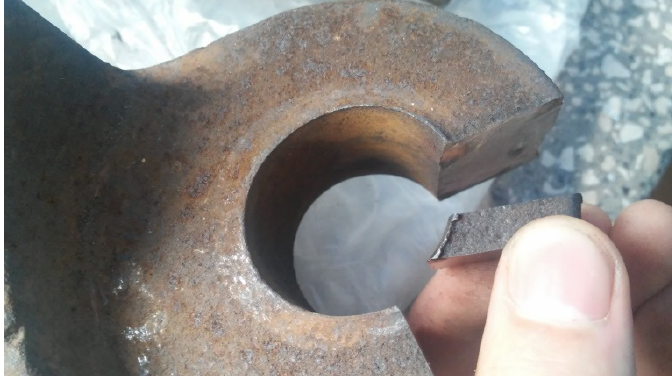
Figure 6. Method of cutting off test samples for metallographic tests.